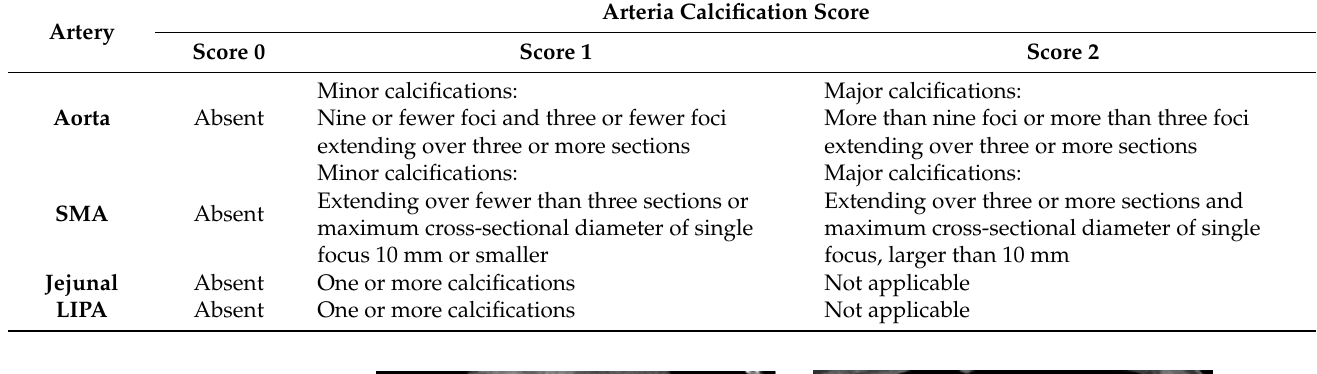
Table 1. Modified visual arterial calcification grading system.